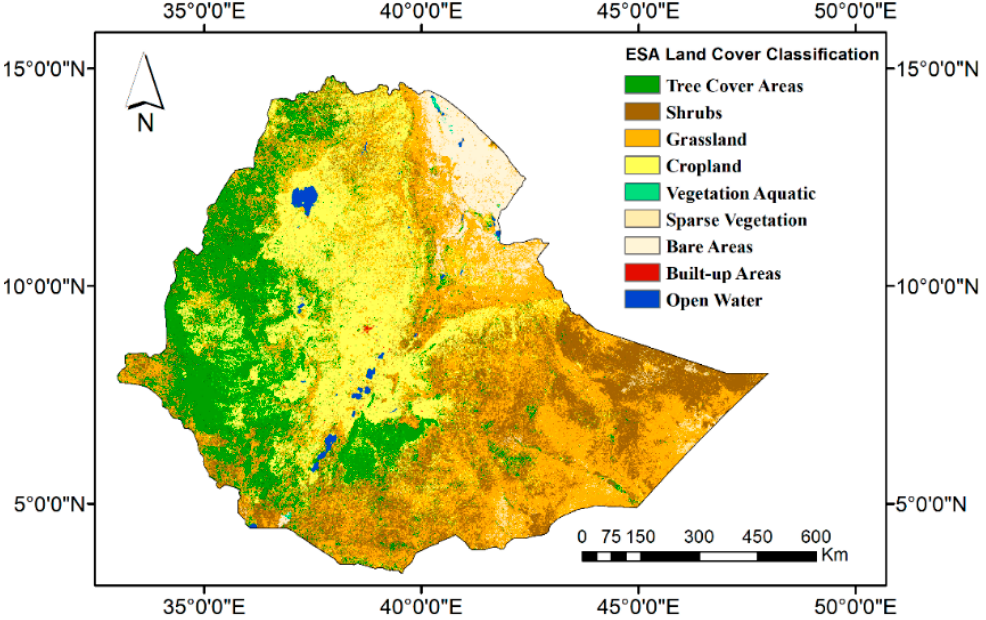
Figure 3. Land cover map of Ethiopia at 20 m spatial resolution during 2016, extracted from the European Space Agency.